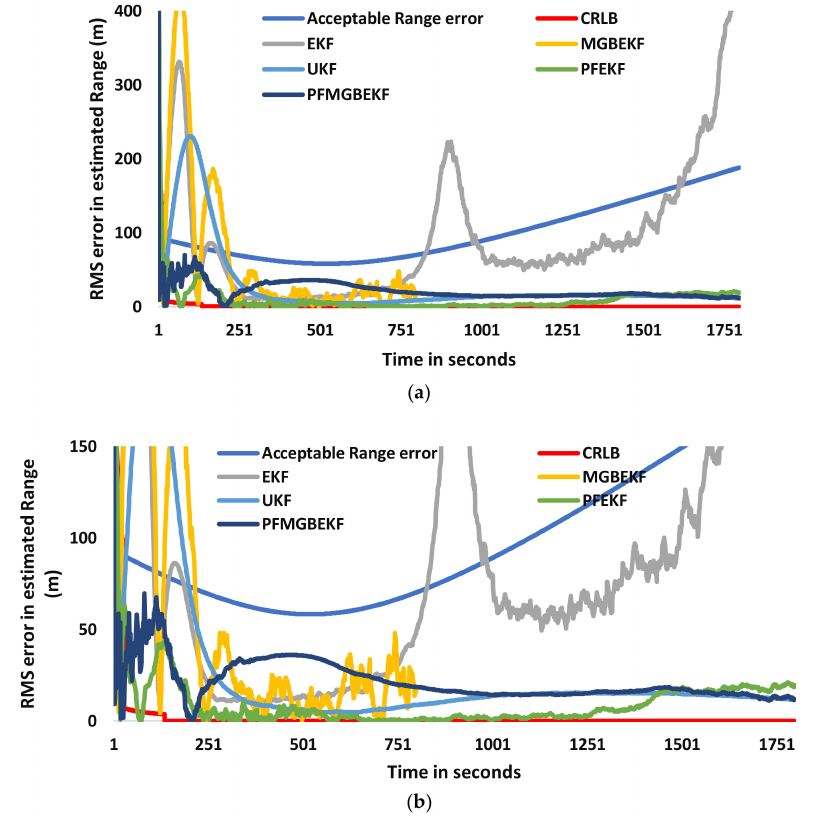
Figure 8. RMS error in range estimate of the target for scenario 3. ( a ) RMS error in range estimate of the target. ( b ) Expanded view of Figure